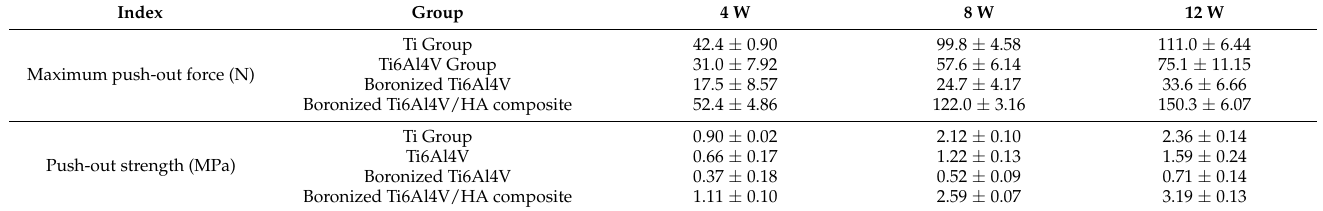
Table 2. Maximum push-out force and push-out strength after surgery at the 4th, 8th, and 12th